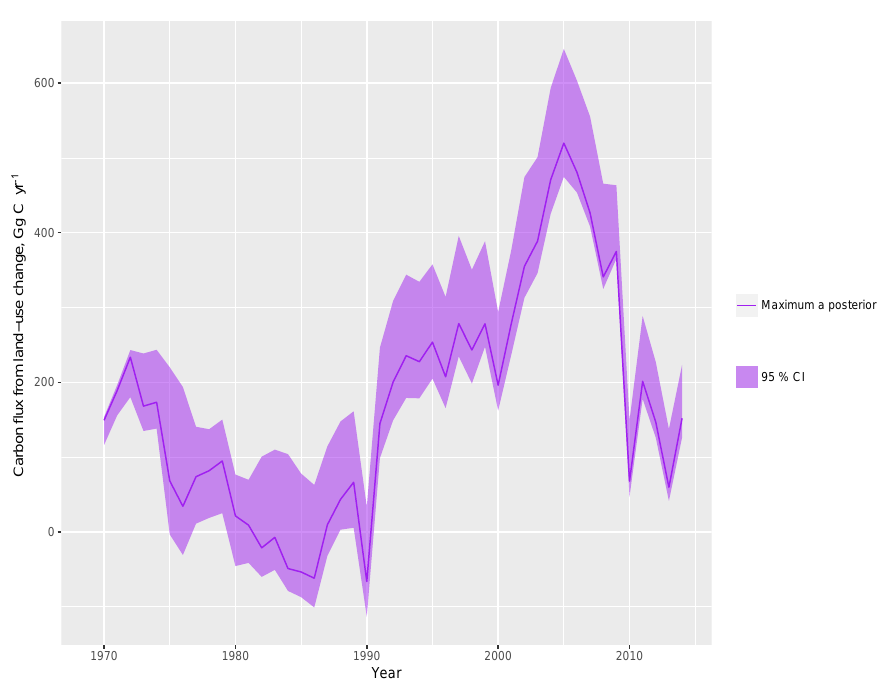
Figure 11. Total net carbon flux from land-use change in Scotland over 1969–2015, showing the maximum a posteriori estimate and the 95% credibility interval. Positive fluxes denote a gain to the terrestrial carbon stock; negative fluxes represent a loss to the atmosphere.